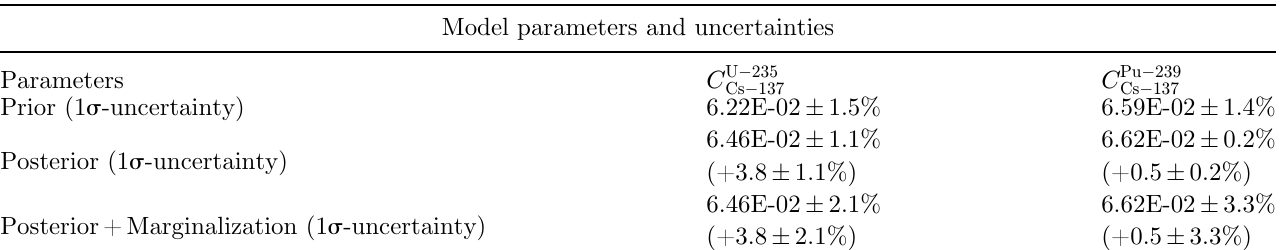
Table 4. Results of the DARWIN2.3 integral data assimilation on 235 U and 239 Pu fi ssion yields. Model parameters and uncertainties